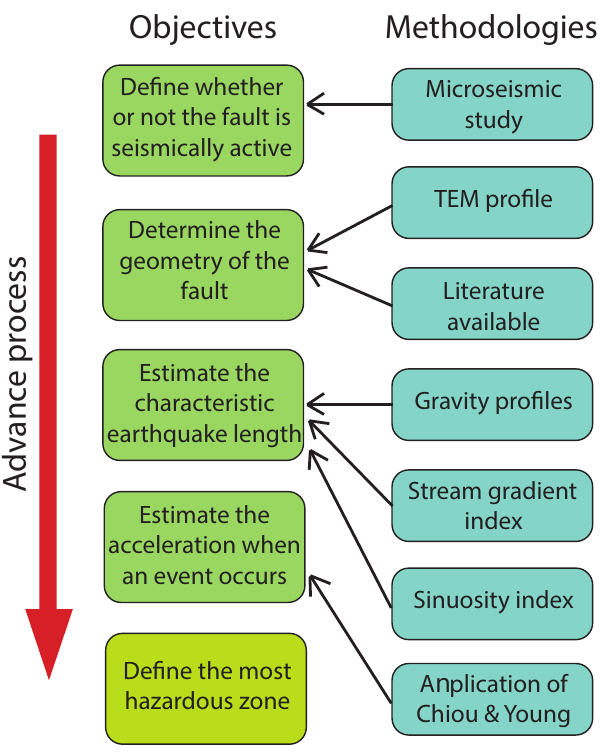
Figure 2. Scheme of objectives and methodologies used in this work. In yellow the final objective.